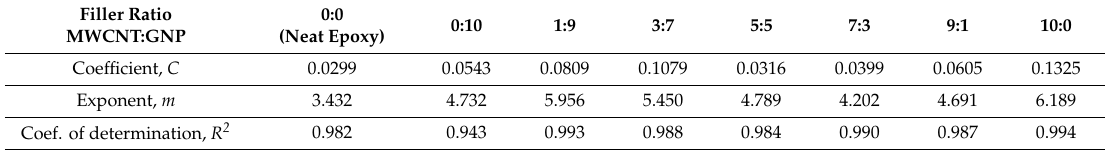
Table 6. Fitting results of the Paris law for the studied nanocomposites with various MWCNT / GNP ratios. Filler Ratio